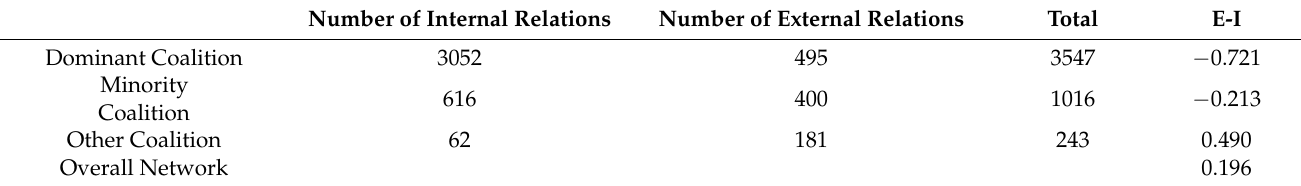
Table 2. E-I index of networks